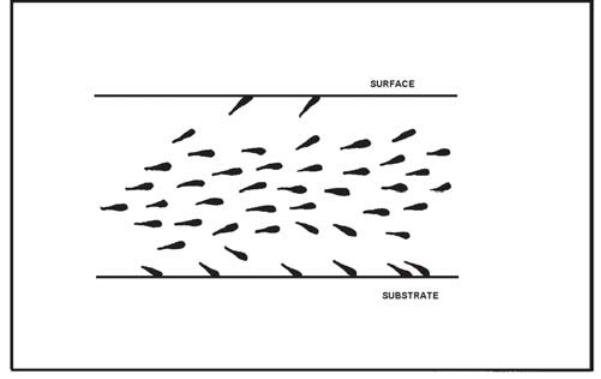
Fig. 2. The distribution of individuals of Mugil curema in the water column while feeding, in a slow-movement school pat- tern, with polarized individuals (viewed as a cross-section of the stream).